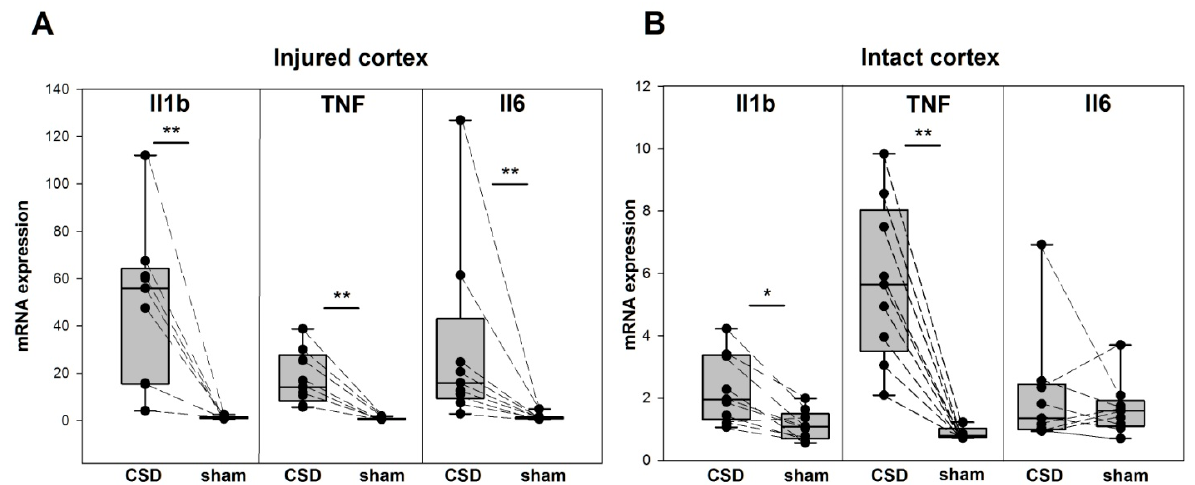
Figure 3. Proinflammatory cytokine expression following a single CSD in the injured and intact regions of the cerebral cortex. Levels of Il1b, TNF, and Il6 mRNA (medians with interquartile ranges and individual data from each rat, n = 9) in the perilesional tissue of the somatosensory cortex ( A ) and in the intact tissue of the frontal cortex ( B ) of the lesioned (CSD) and opposite (sham) hemispheres. * p < 0.017 and ** p < 0.0085—ipsilesional versus sham-treated cortical regions (post hoc Wilcoxon test with Bonferroni